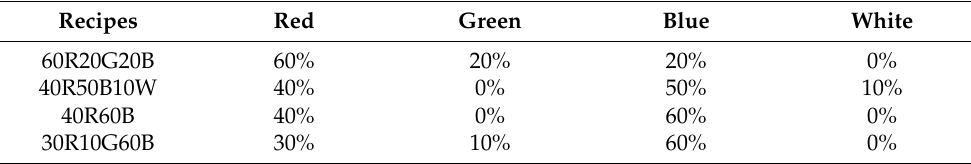
Table 2. Light treatments (recipes) for the second dataset (Test